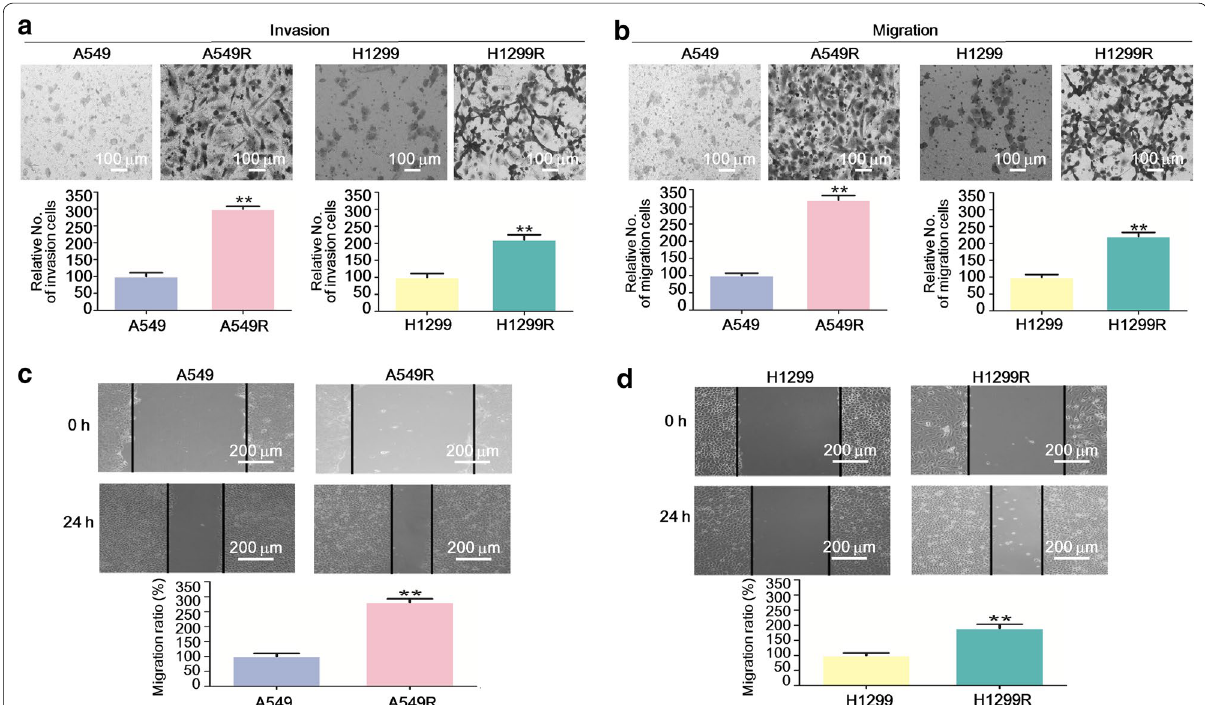
Fig. 3 The radioresistant non‑small cell lung cancer cells showed enhanced ability of invasion and migration. a , b Transwell matrigel invasion and migration assays with A549, A549R, H1299, and H1299R cells. The cells were stained with crystal violet, counted under a light microscope, and photographed at 200 magnification. The cell number was normalized to A549 or H1299 cells, respectively, and are presented as mean × deviation (SD). ** P < 0.01 (Student’s t test). c , d Wound healing assay with A549, A549R, H1299, and H1299R cells. Representative pictures are shown, and the width of the wounds was measured at 0 and 24 h after the scratch. The migration rate was normalized to A549 or H1299 cells, respectively, and is presented as mean SD. ** P < 0.01 (Student’s t ±